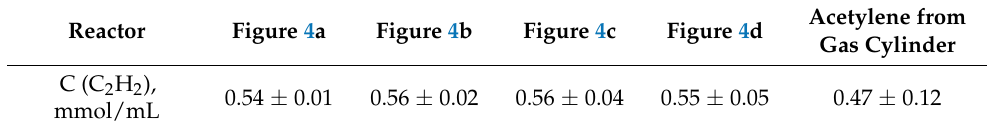
Figure 4. 3D printed plastic reactors with distributors of different shapes (arrow points on gas exhaust holes): ( a )—conical; ( b )—cylindrical; ( c )—spherical; ( d )—without a tip. Table 2. Concentrations of acetylene in DMSO depending on feeding